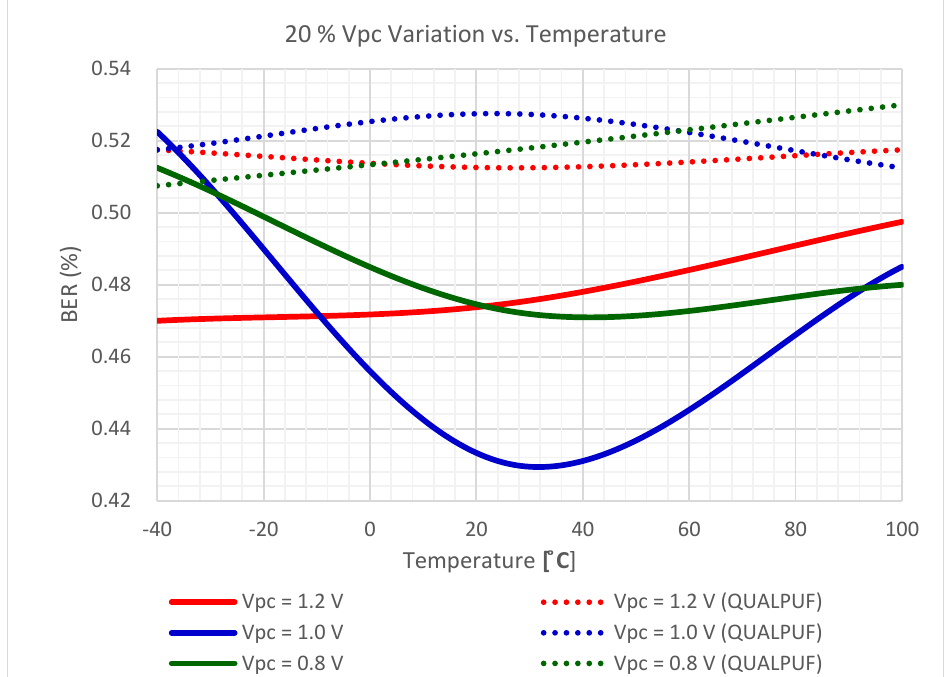
Figure 11. The BER of the proposed FinFET-based TPCA-PUF (labeled as Prop.) versus QUALPUF under the ±20% supply voltage variation (4-bit PUF).